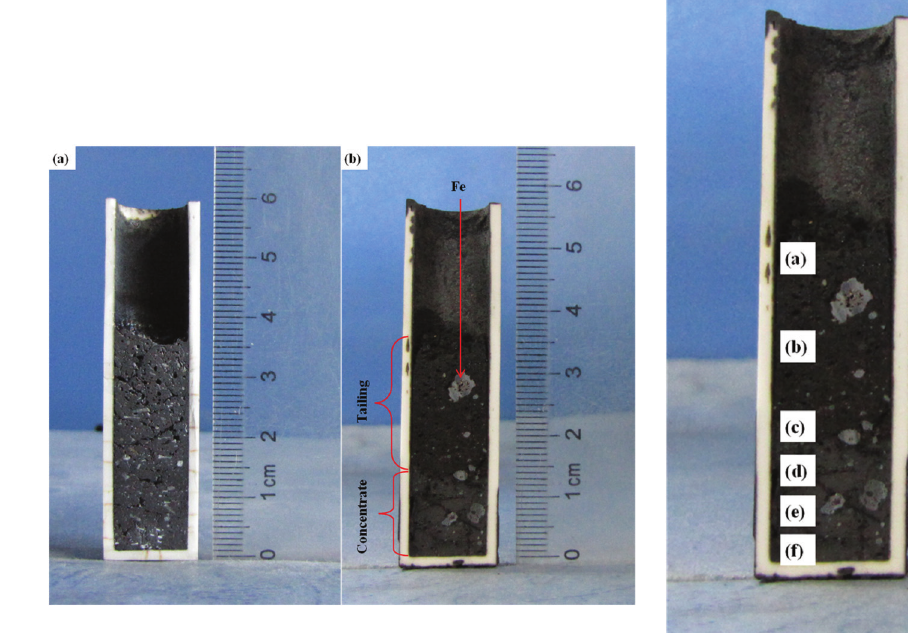
Fig. 4: Positions of six areas of the sample obtained by centrifugal concentration at G = 1050, t = 30 min, T = 1523